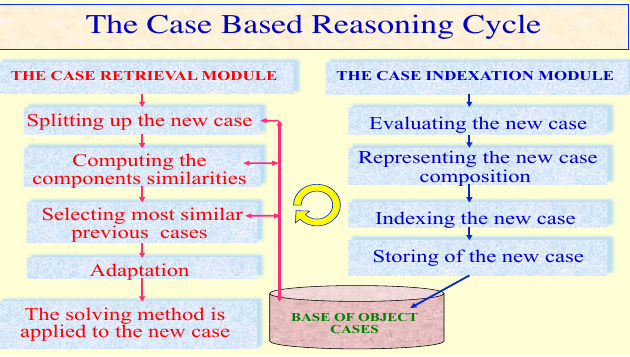
Figure 15. A Case Based Reasoning Cycle